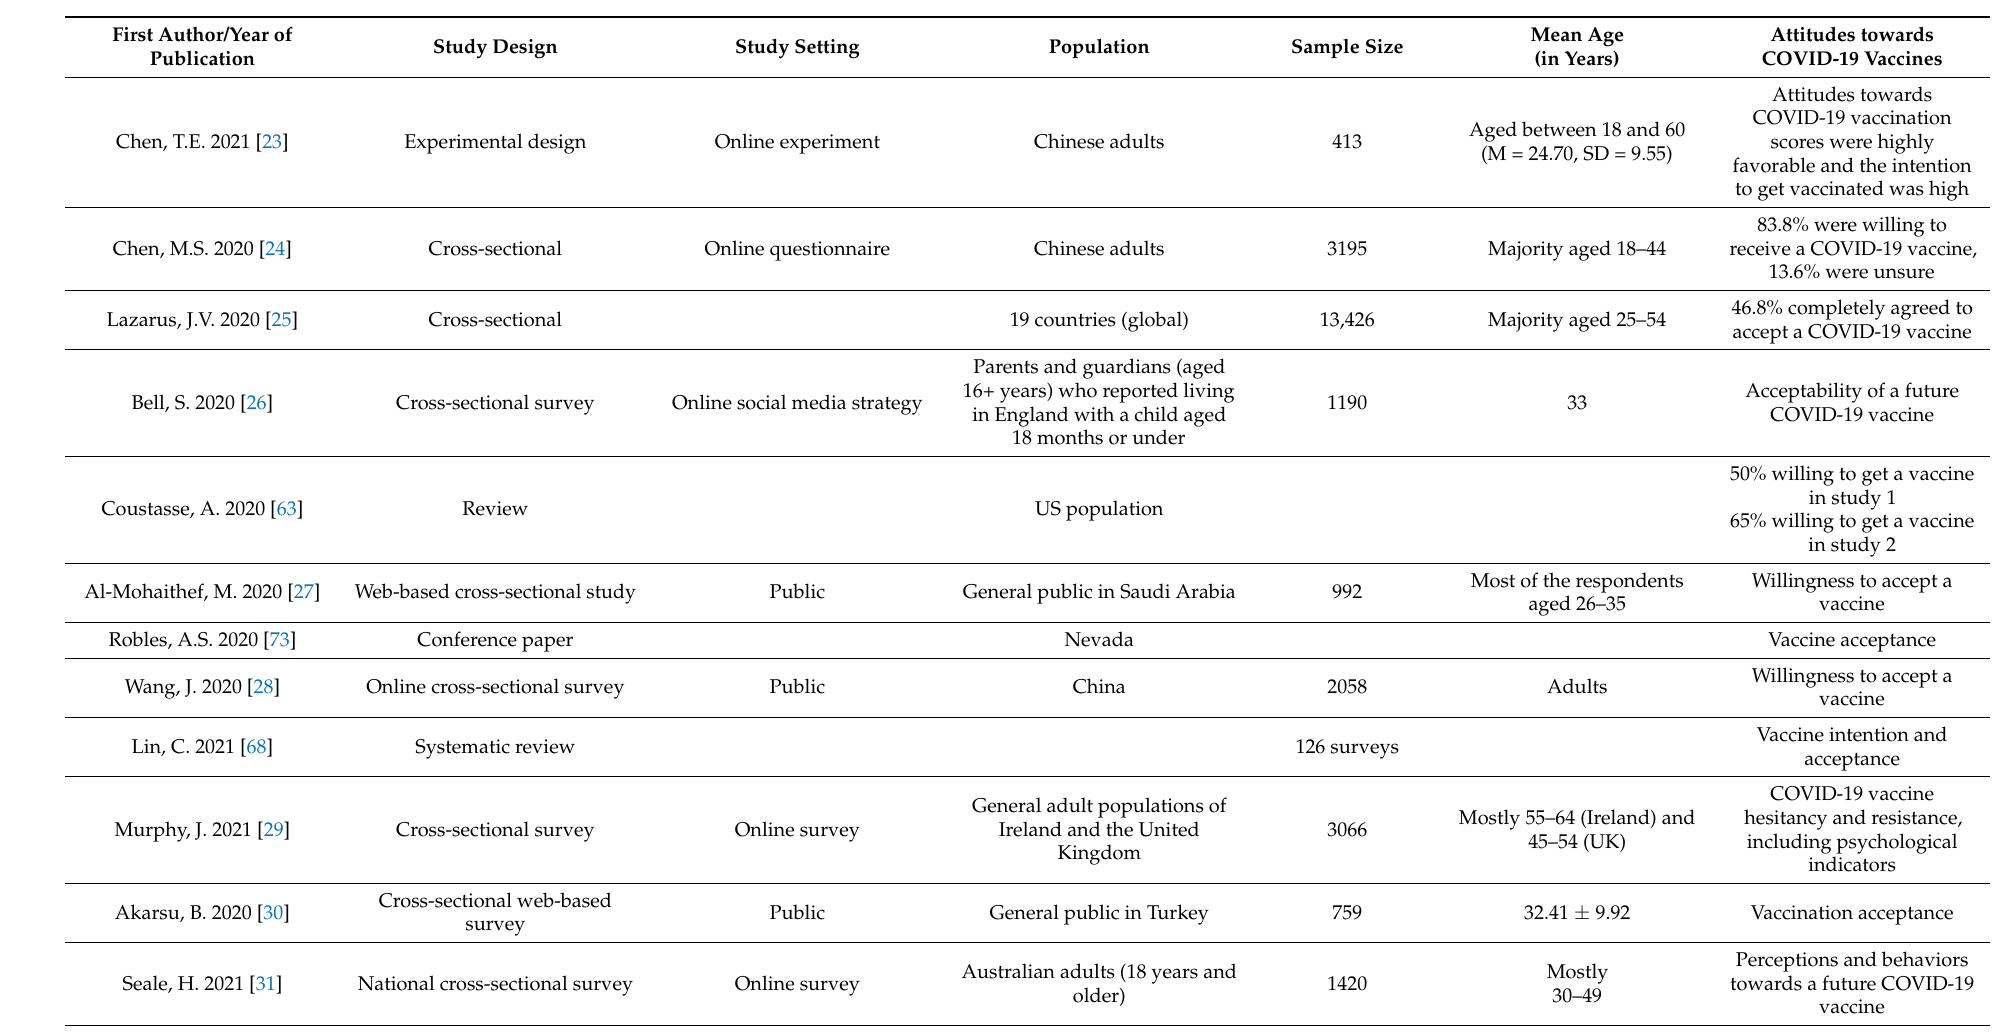
Table 2. Baseline characteristics of the selected